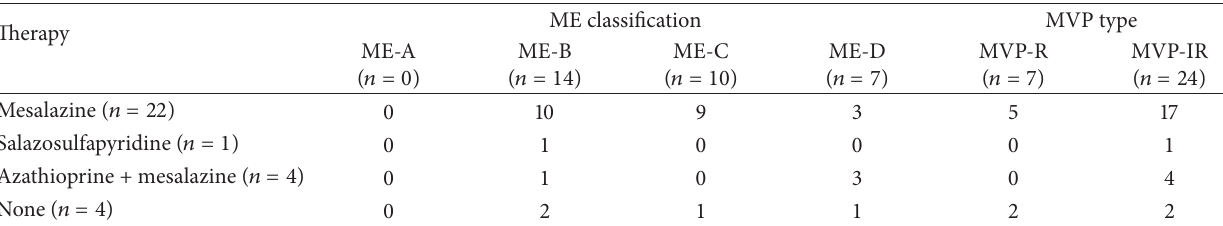
Table 2: Summary of relationship between ulcerative colitis treatment, magnifying endoscopic (ME) classifications following crystal violet staining, and microvascular pattern (MVP) in cases of Matts-2 endoscopic grade. Therapy